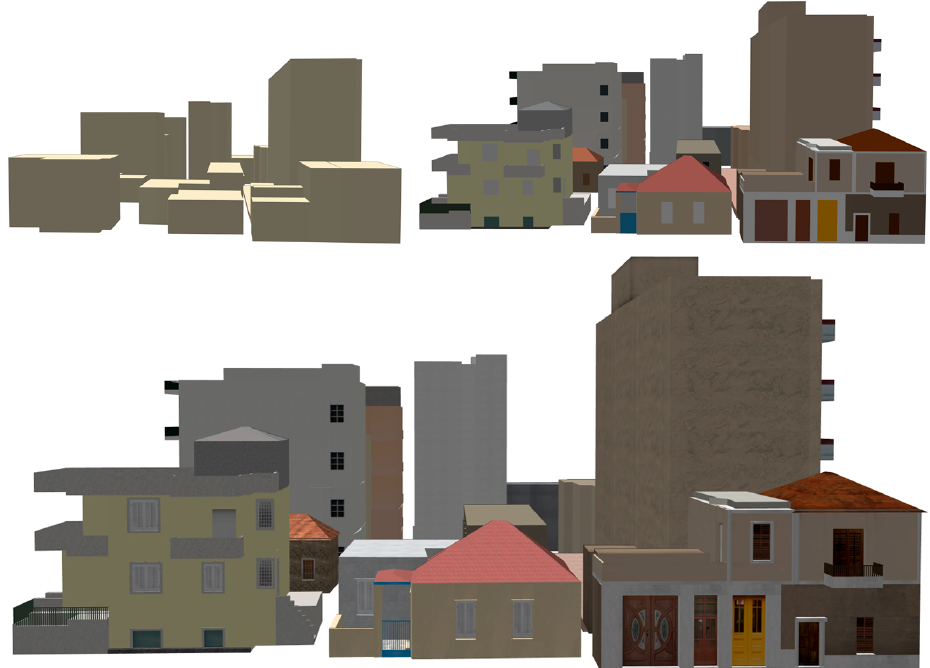
Figure 3. 3D views of the building models at LoD1 ( top-left ), LoD2 ( top-right ) and LoD3 ( bottom